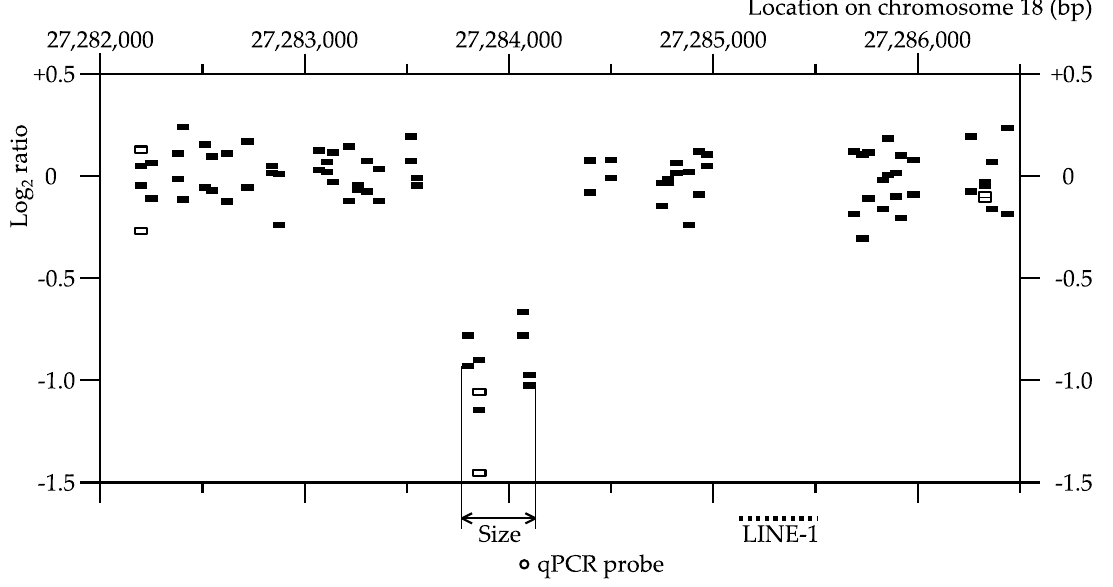
Figure 2. Example of a de novo CNV. The copy number profile of one of the deletions found in an F1 mouse (ID: 20mGyY1). The horizontal axis represents the chromosomal location, and the vertical axis represents the Log2 ratio of fluorescence between the sample and the reference for each probe. The results of two hybridization experiments with dye swapping are plotted separately. Open rectangles indicate the results of the first array CGH; black rectangles indicate the results of the second array CGH; the double-headed arrow indicates the estimated size of the CNV; the small open circle indicates the location of the qPCR probe (TaqMan probe); and the dotted line indicates the location of the LINE-1 repetitive sequence, which might hamper probe design.